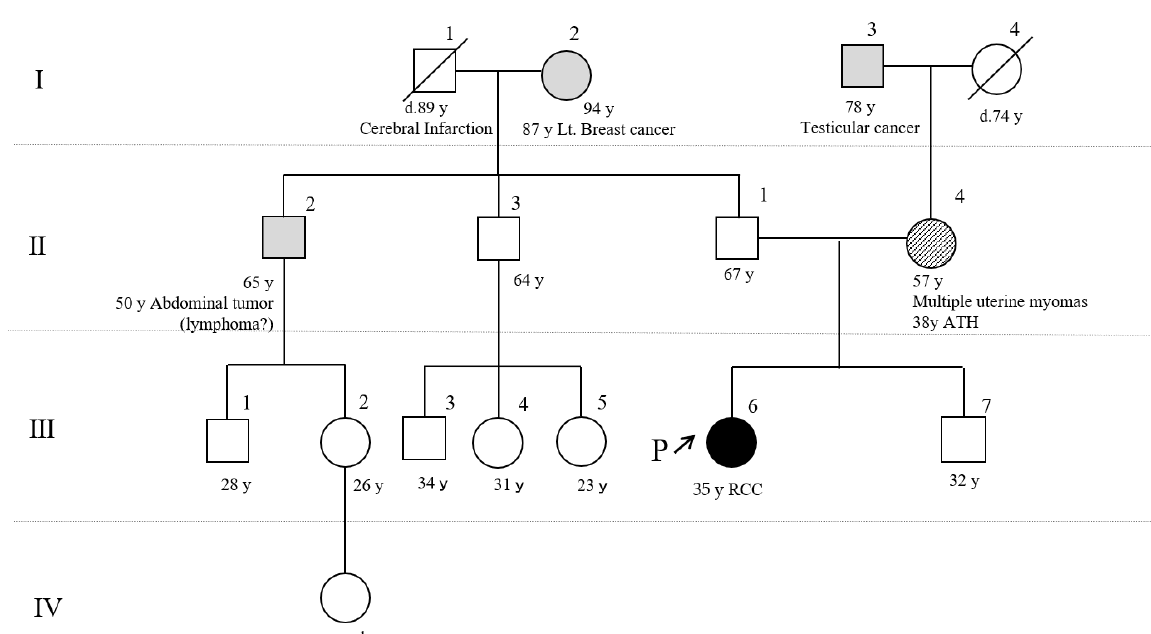
Figure 3. Pedigree of the patient. She (III -6) was diagnosed with RCC at the age of 35 years but had neither skin tumors nor a family history of hereditary leiomyomatosis and RCC (HLRCC). Her mother (II-4) had uterine fibroids and had undergone an abdominal total hysterectomy at age 38 years. The inherited pathological FH variant was suspected of originating from her mother. ATH, abdominal total hysterectomy; P, our patient; Roman numerals represents generation numbers; Arabic numerals represents individual numbers.